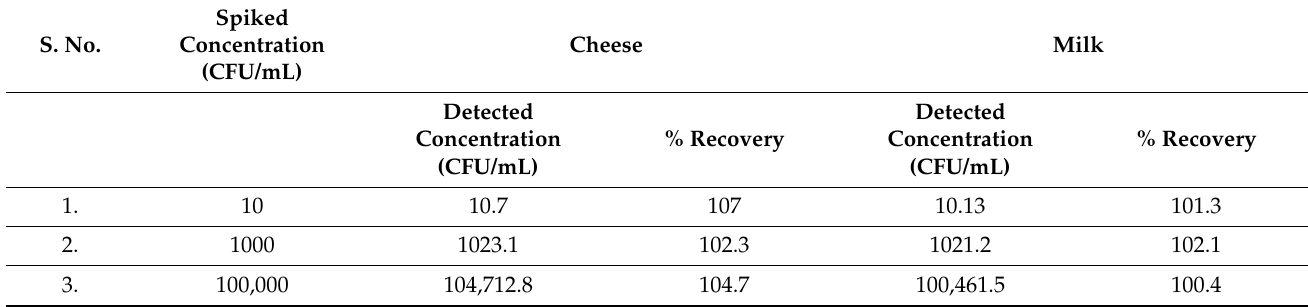
Figure 6. Charge transfer resistance observed for spiked cheese and milk. The response to bacteria is also shown for reference in 0.1 M KCl containing 0.1 mM methylene blue (frequency range of 100 Hz–10 MHz). Table 2. Percentage recovery of bacteria concentrations in cheese and